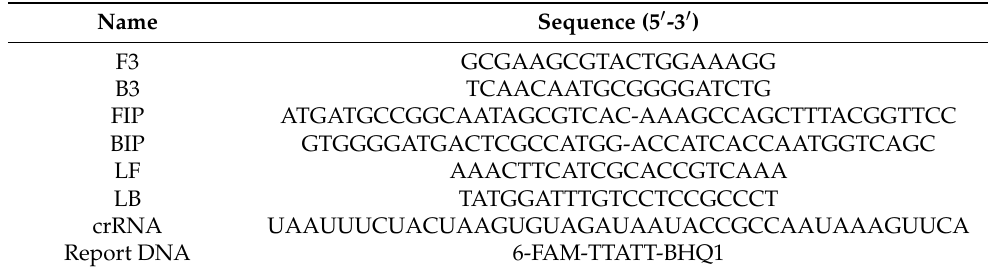
Table 2. The sequences of primers, crRNA, and report